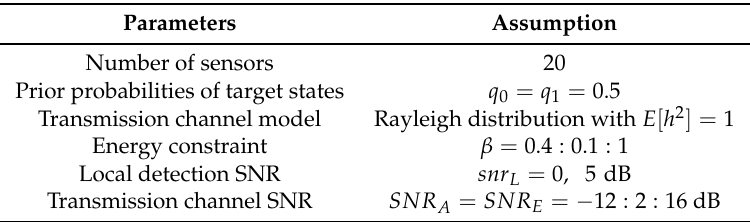
Table 1. Simulation Parameters in Wireless Sensor Network.